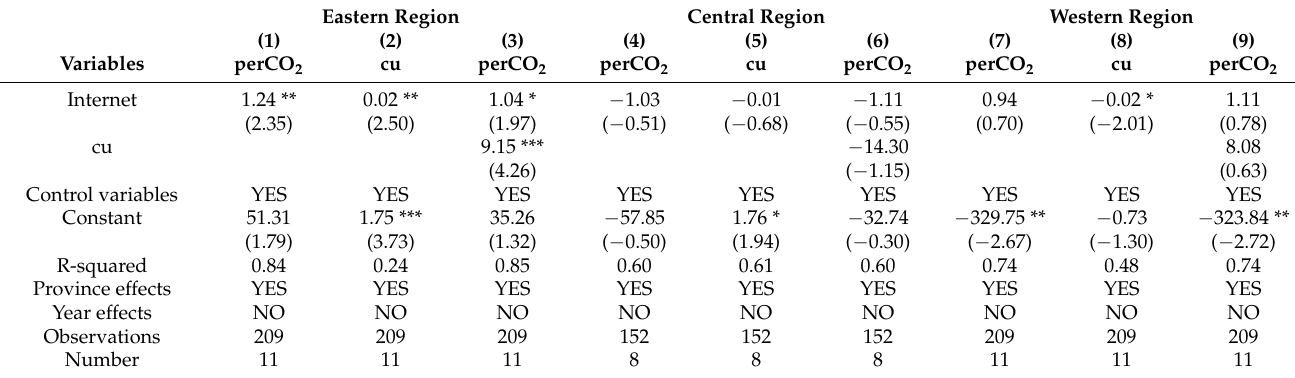
Table 7. Heterogeneity impact results.